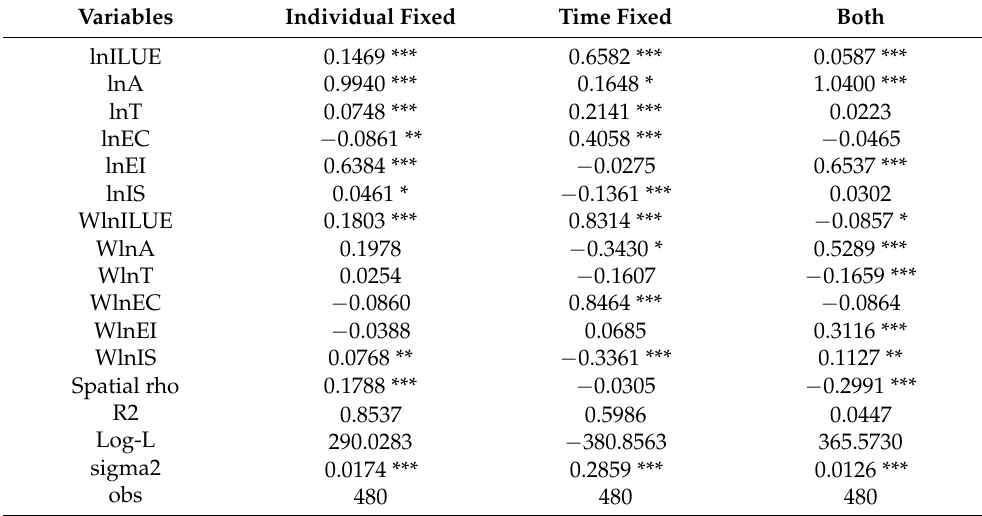
Table 6. Results of Durbin regression.